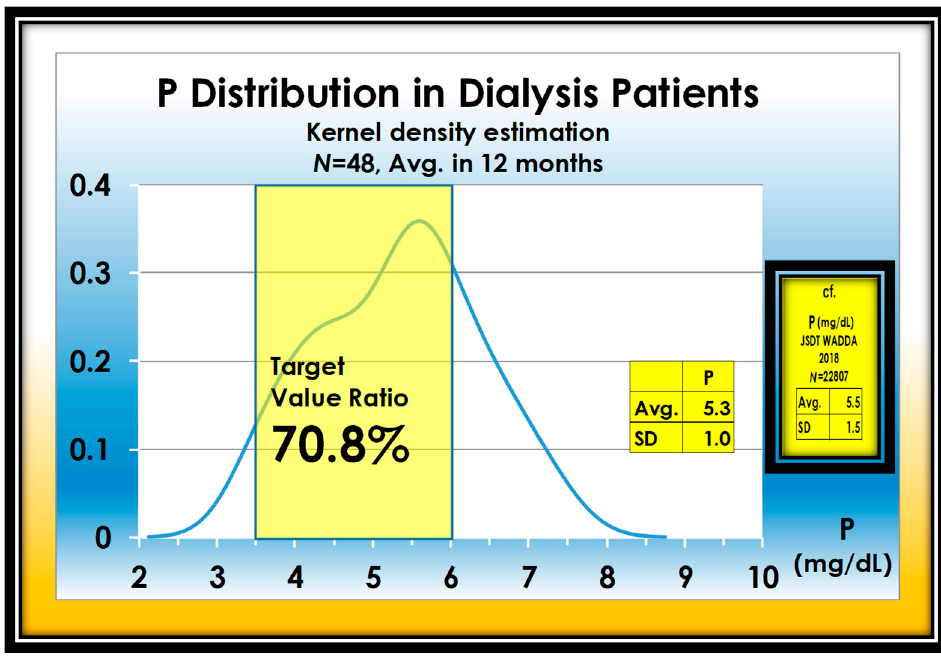
Figure 2. Adequate ratio of serum P in 48 dialysis patients. Even with considerable effort, only 70.8% were able to reach the proper value for P. However, this value is better than 66.2% of JSDT WADDA. (Figure 3).